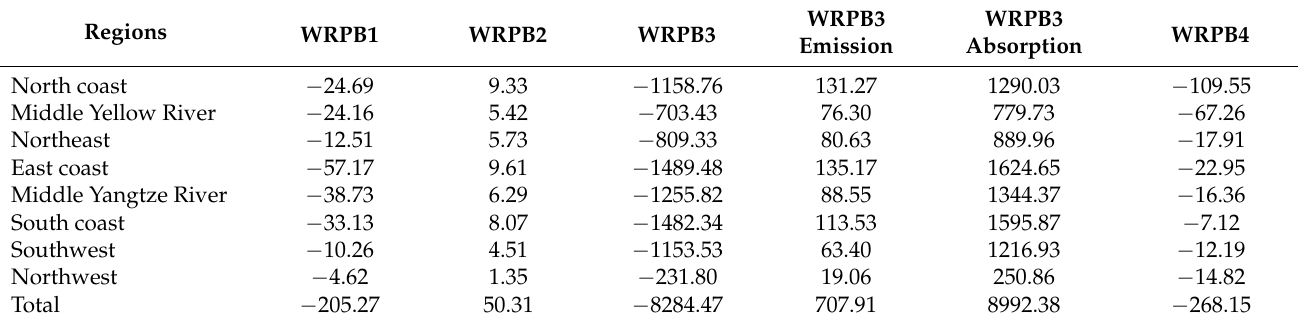
Table 7. CEE of WRPBs in eight regions of China in 2020 (10,000